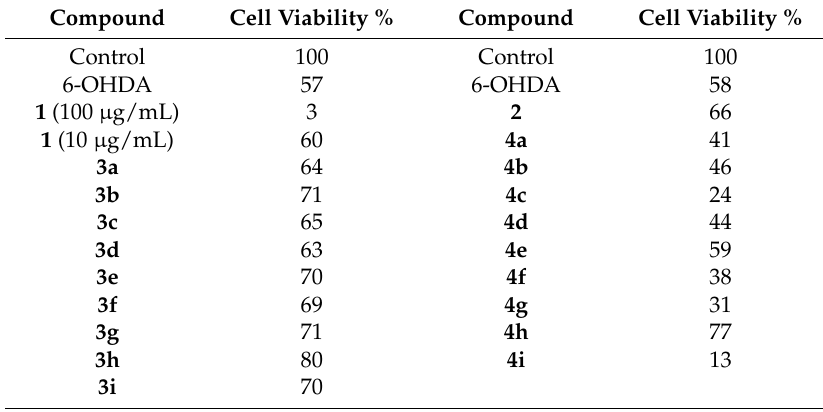
Table 2. Cell viability values of 6-OHDA and compounds 1 , 2 , 3a – i , 4a – i according to the cell viability assay results. The results of the cell viability were presented as a % of the control (the O.D.